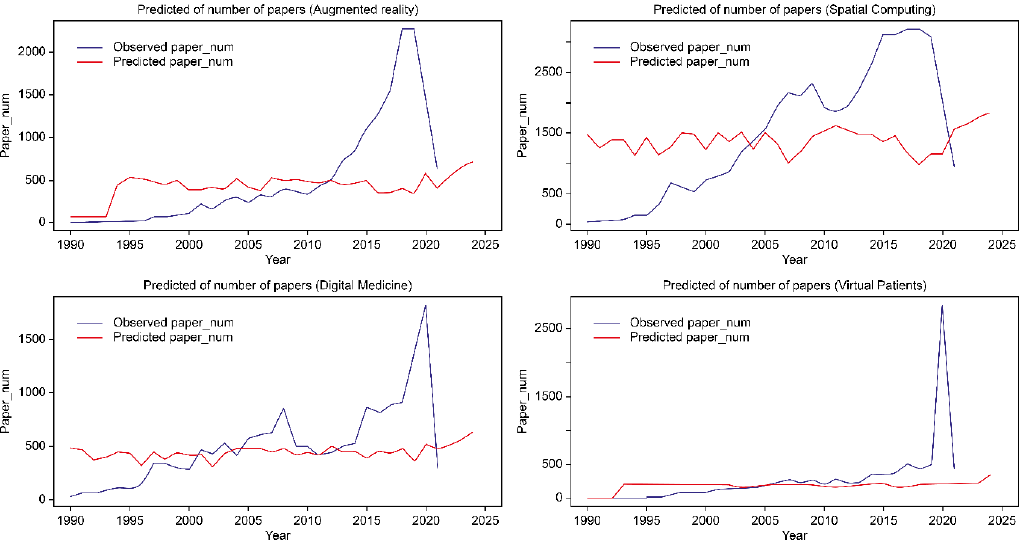
Figure 4. Number of Science Citation Index (SCI) papers in the input data and the predicted number of SCI papers per year for the technology predicted as a future promising technology.